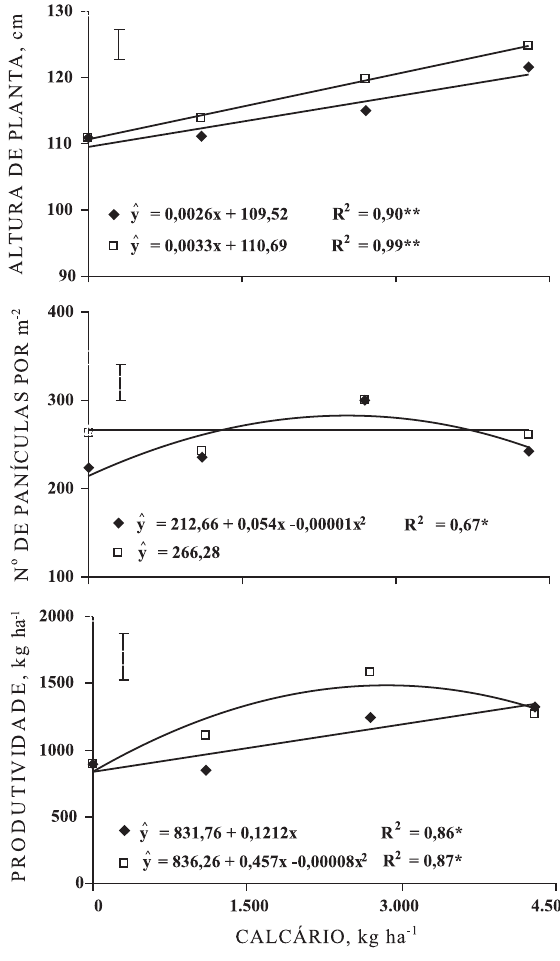
Figura 3. Altura de planta, número de panícula por m -2 e produtividade de grãos de aveia-preta em função da calagem em superfície, sem ( ) e com ( ) a aplicação de gesso, no ano de 2003. * e ** são significativos a 5 e 1 % pelo teste t. Barras verticais indicam o valor de DMS pelo teste t (p =